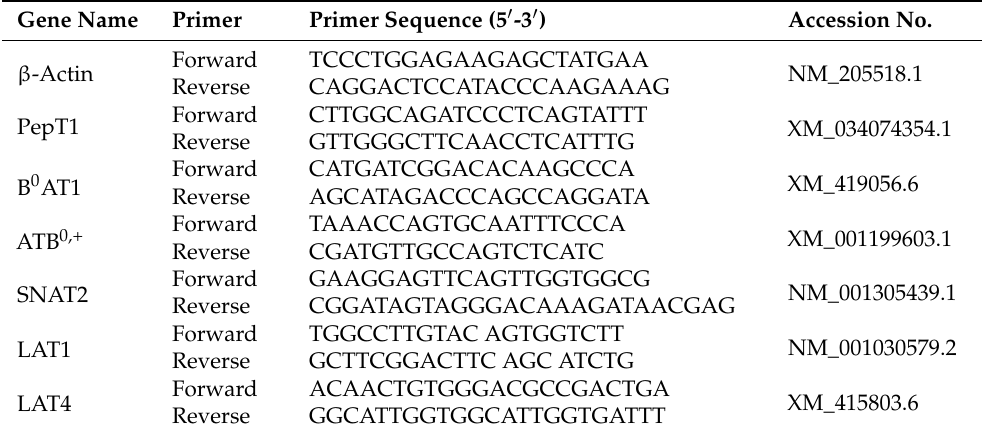
Table 2. Primers used for quantitative real-time